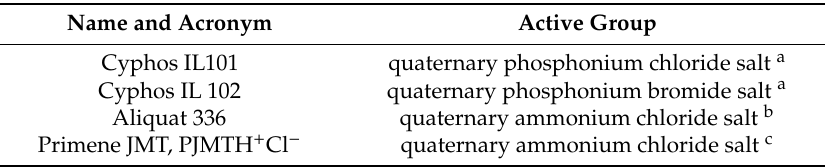
Table 6. Ionic liquids used in the transport of gold(III).